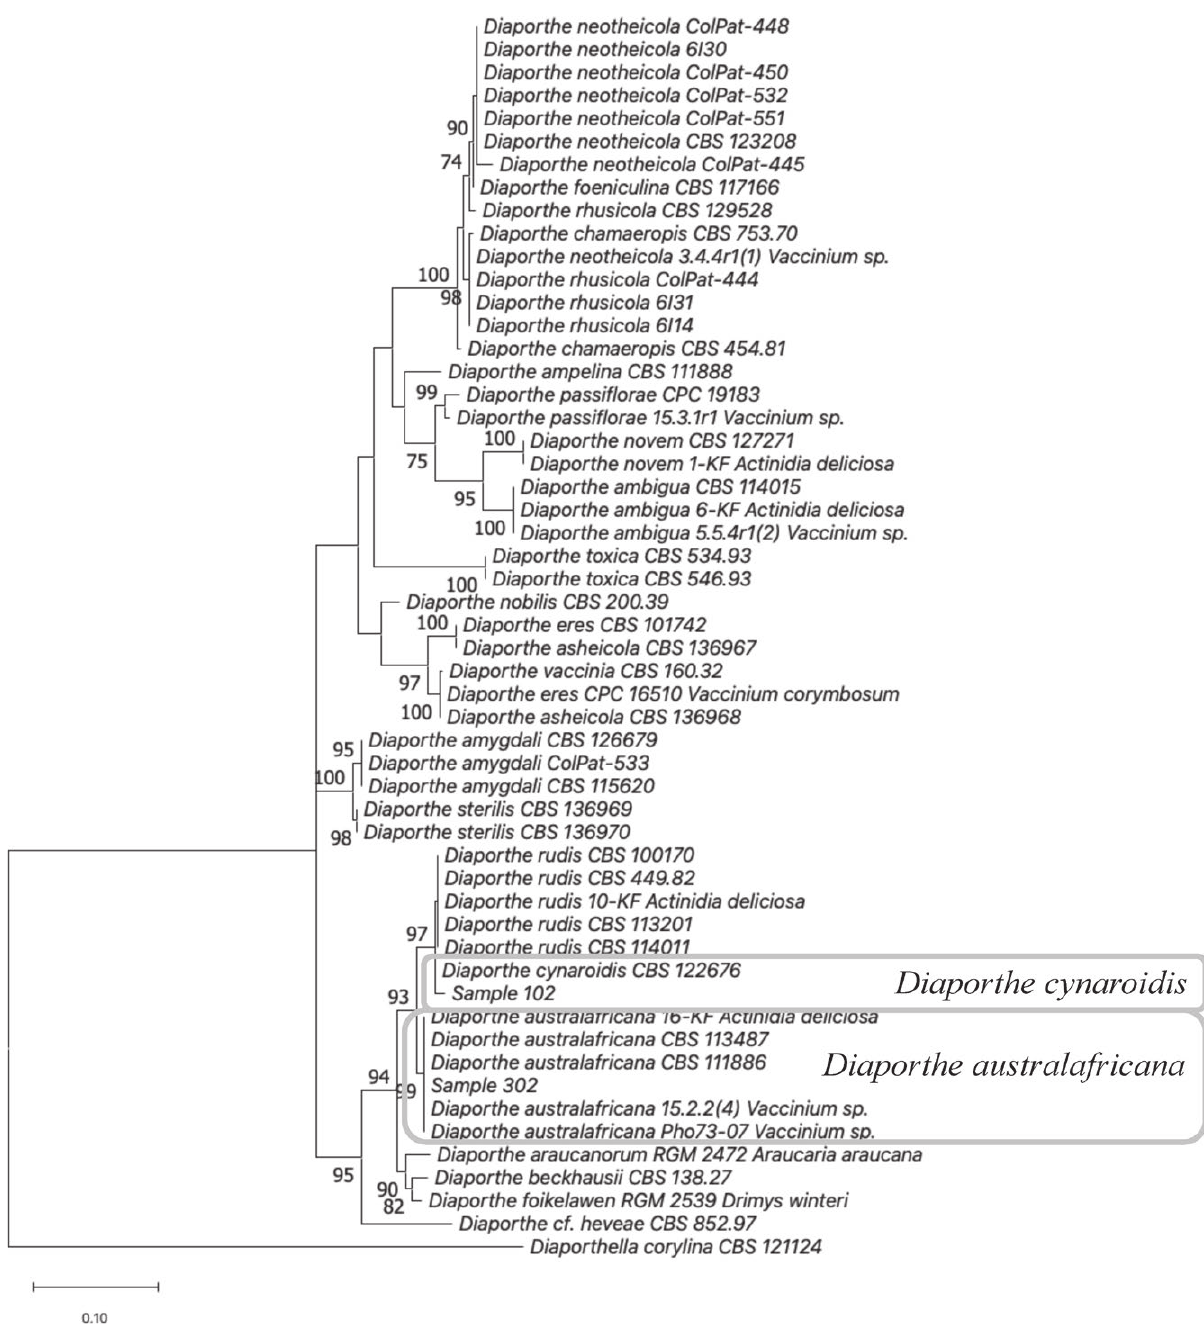
Figure 4. Phylogenetic tree reconstructed by maximum likelihood analysis from the sequences of the nuclear ribosomal internal transcribed spacer for two novel Diaporthaceae taxa recovered from two walnut orchards in Chile, and 51 GenBank sequences of Diaporthaceae that included reference sequences as well as sequences of previously reported Chilean walnut pathogens. The tree is drawn to scale, with branch lengths measured in the number of substitutions per site. Numbers on branches are bootstrap support